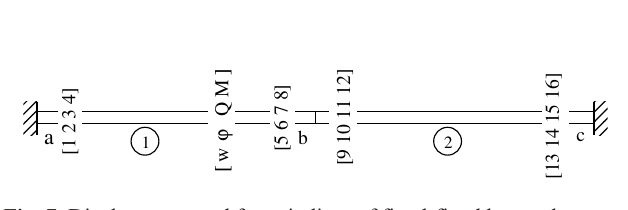
Fig. 7. Displacement and force indices of fixed-fixed beam elements.